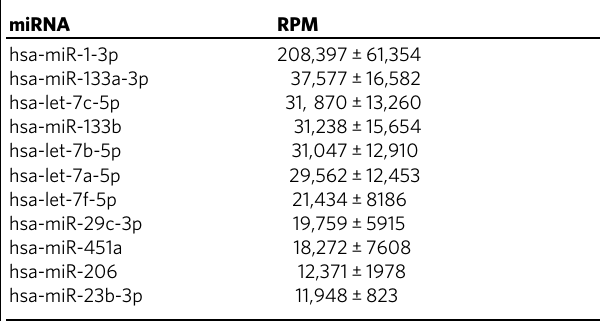
Table 1 Most abundant miRNAs in human skeletal muscle